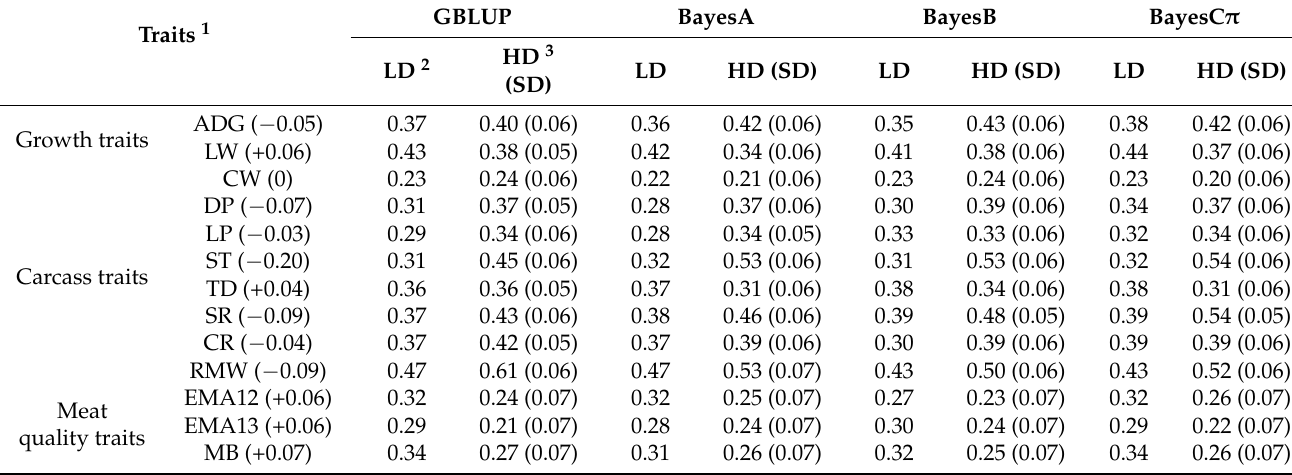
Table 2. Predictive accuracy of GEBVs for the low-density SNP panel using different methods. Traits 1